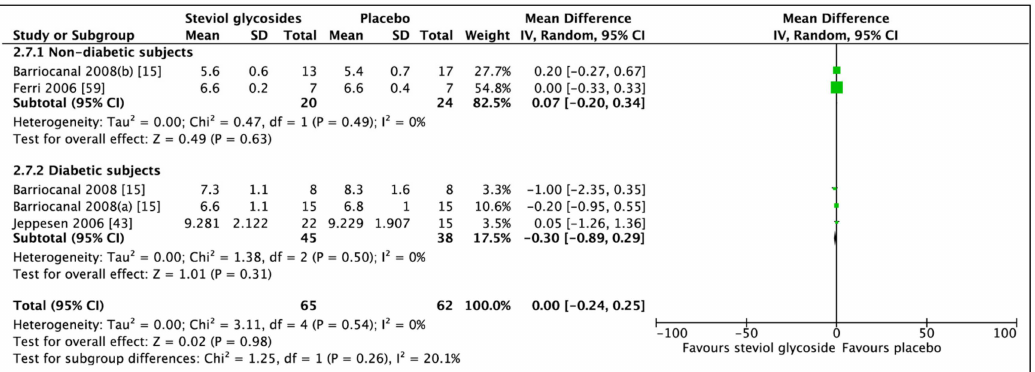
Figure 12. E ff ect of SGs on glycated hemoglobin (HbA1c, %) CI: confidence interval; MD: mean di ff erence; RCTs: randomized controlled trials; SD: standard